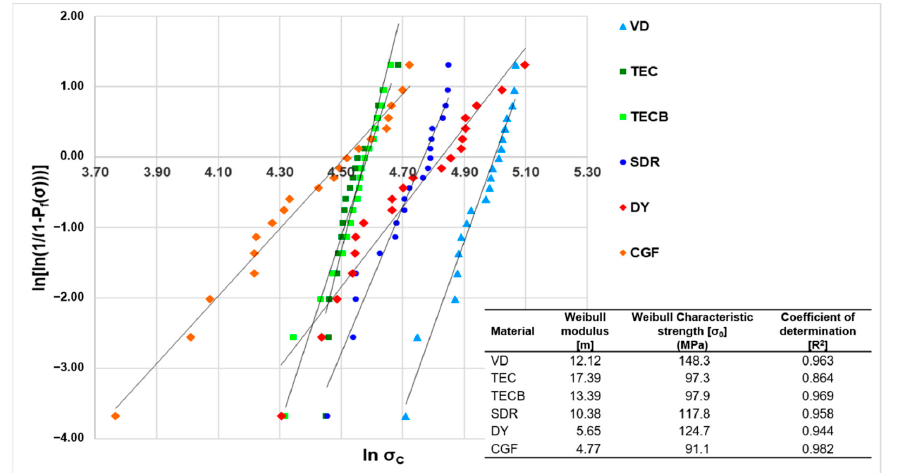
Figure 5. Weibull distribution as a function of material. Weibull modulus m, characteristic strength σ 0 which is the strength at a probability of failure (P f ( σ )) of 63.2%, and the coefficient of determination R 2 which describes the overall fit to the projected linearity.